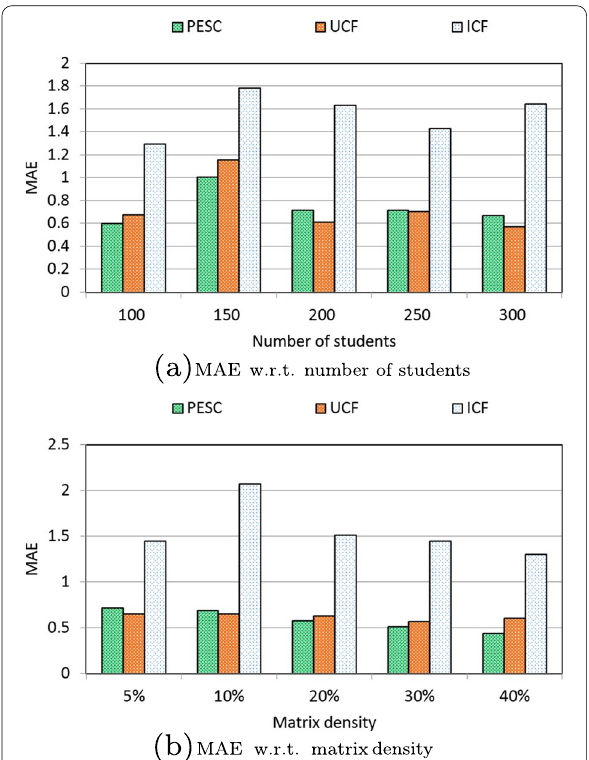
Fig. 4 Time cost